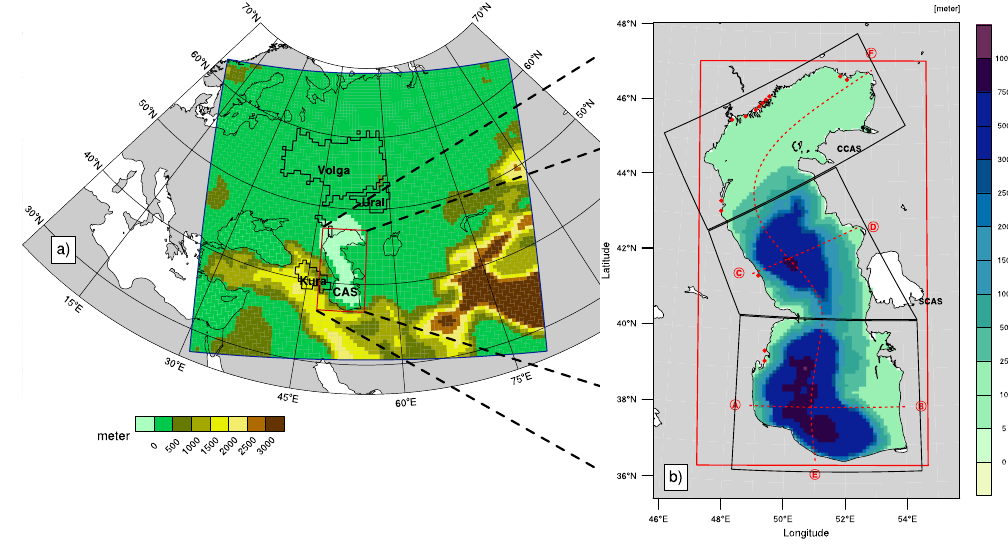
Fig. 3. RCM domain, topography and ocean model bathymetry. (a) Caspian Sea (CAS) region domain and topography used in the RCM simulations. The outer blue solid box is the 50km RCM domain and inner red solid box is the ROMS ocean model domain. The regions indicated by solid black lines, which are the main basins (Volga, Ural and Kura), extracted from TRIP dataset. (b) Ocean model bathymetry, defined river locations, sub regions and